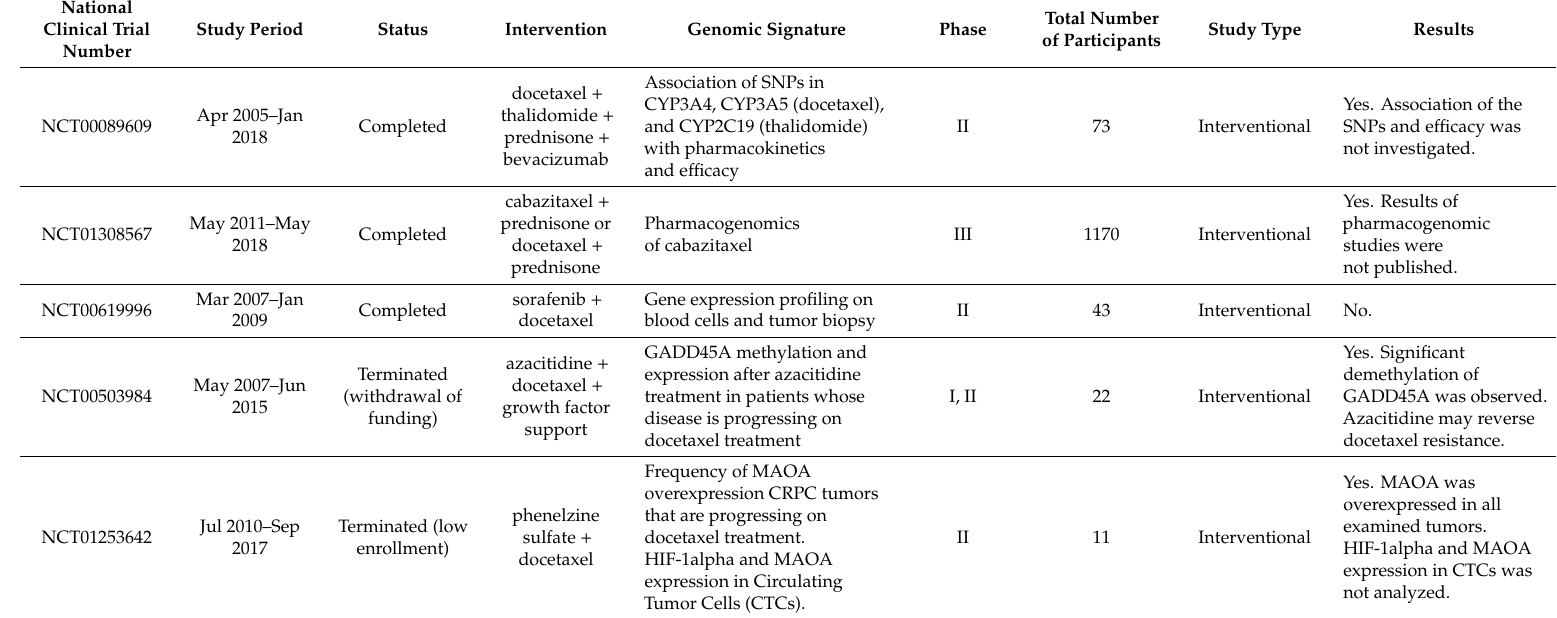
Table 2. Completed or terminated clinical trials for docetaxel treatment of prostate cancer